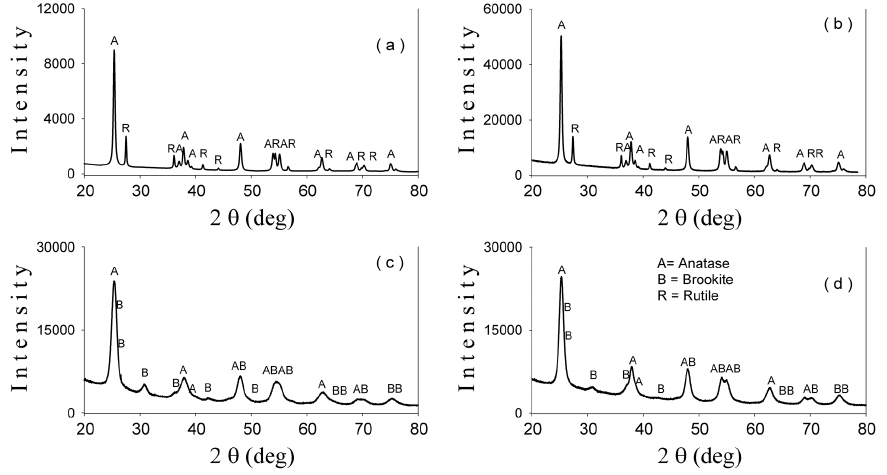
Figure 1. X-ray diffraction (XRD) patterns and phase assignment of the samples: P25 ( a ); P25-1%